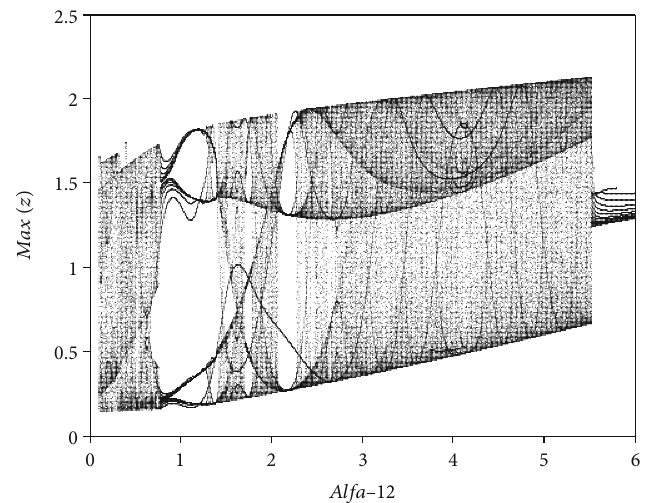
0 : 01 < α < 6 using the parameter values in (90). 12 in the range 12